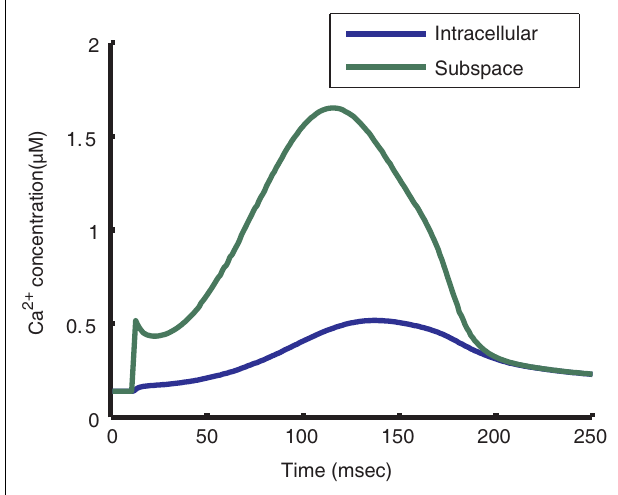
FIGURE 9 | Predicted subspace Ca 2 + levels. Model cytosolic Ca 2 + transient during a steady-state 1Hz AP (blue) and subspace Ca 2 + transient averaged across all dyads (green).While the average subspace Ca 2 + is approximately four times higher than that of the cytosol, the maximum subspace Ca 2 + for a single dyad may reach 45 µ M, measured as the maximum subspace Ca 2 + for the open-open LCC-RyR configuration during a release